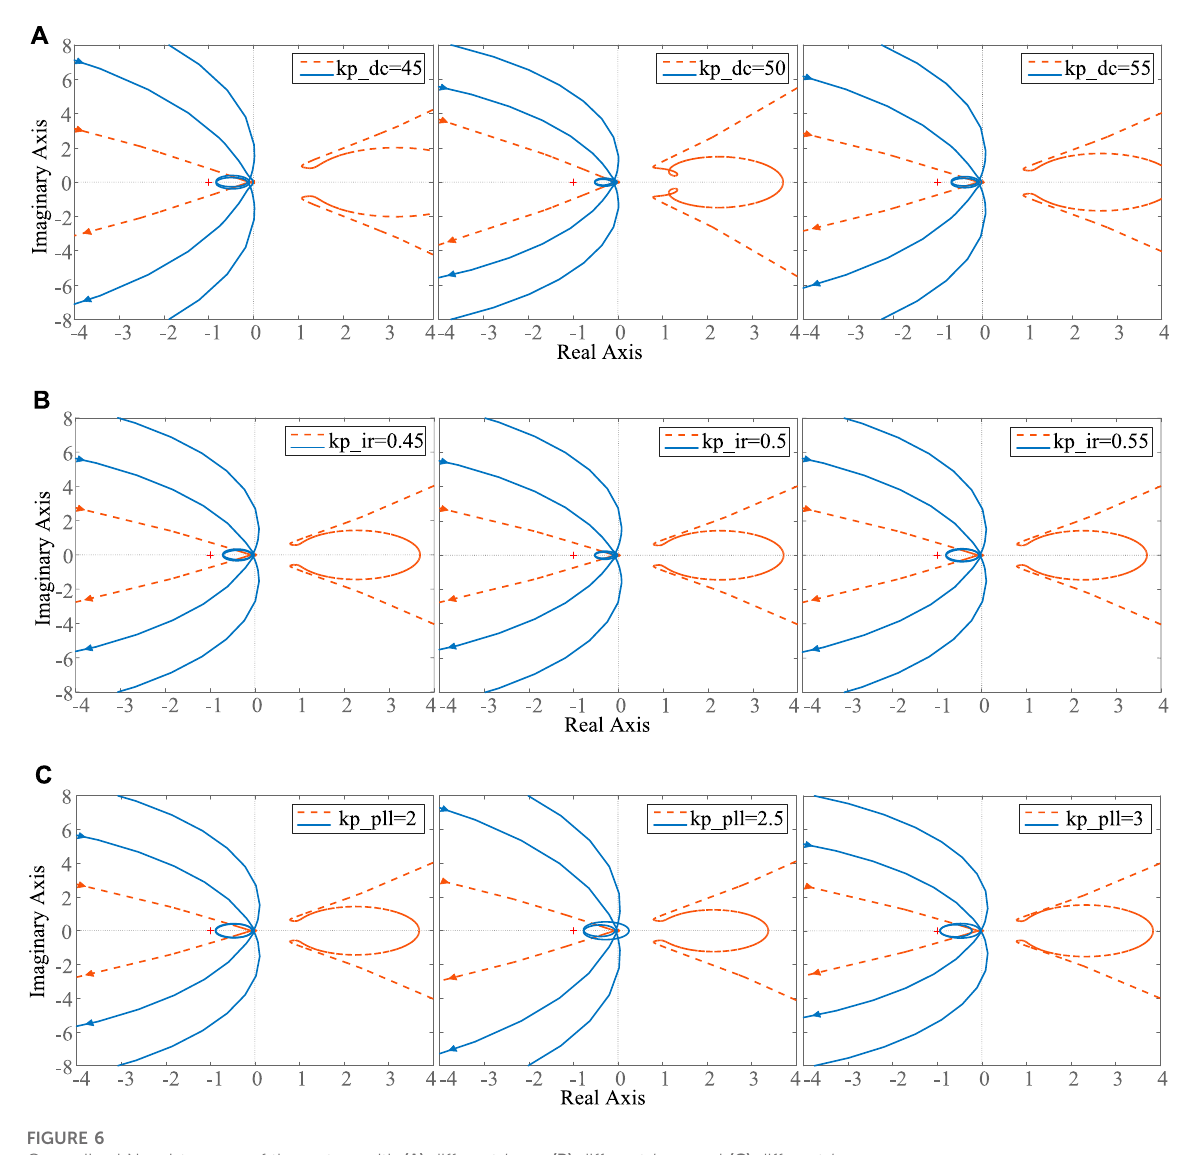
FIGURE 6 Generalized Nyquist curves of the system with (A) different k p dc , (B) different k p ir , and (C) different k p pll .